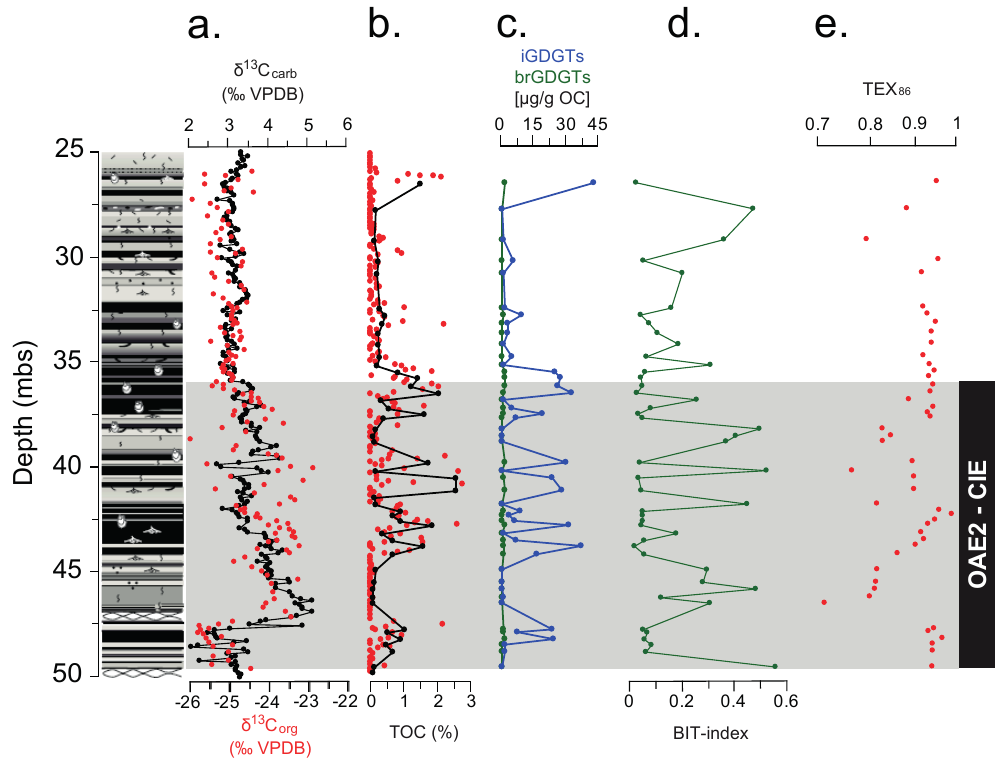
Figure 2. Geochemical results for the Cenomanian–Turonian transition of the Wunstorf core. Stratigraphy from Voigt et al. (2008). (a) δ 13 C carb (Voigt et al., 2008) and δ 13 C org (du Vivier et al., 2014; red). (b) Total organic carbon (TOC: black, this study; red, Hetzel et al., 2011). (c) Concentrations of summed iGDGTs and summed brGDGTs (µgg − 1 OC). (d) BIT index. (e) TEX 86 values. The grey zone indicates the OAE2 interval after Voigt et al.